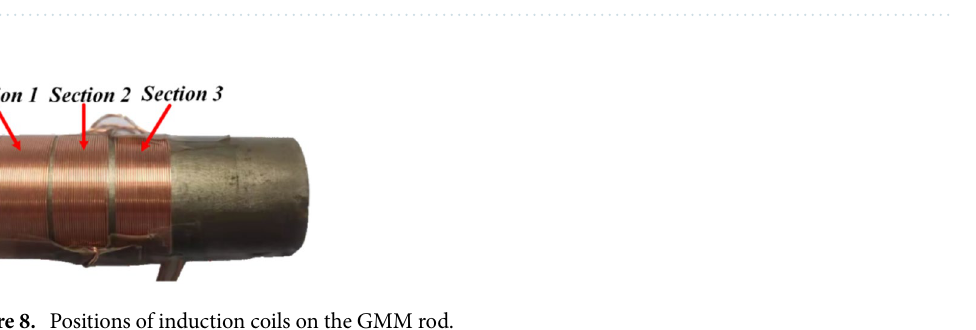
Table 3. Thermophysical properties of the main materials in longitudinal vibration GMT 33–35 .